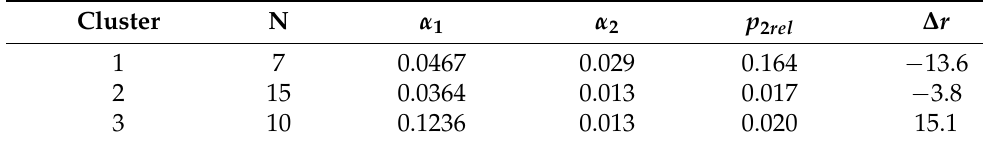
Table 4. Mean values per cluster. While cluster 1 shows a strong decrease of relative position, in cluster 3, the relative rank increases by almost the same amount. In cluster 2, the average rank decreases by 3.8